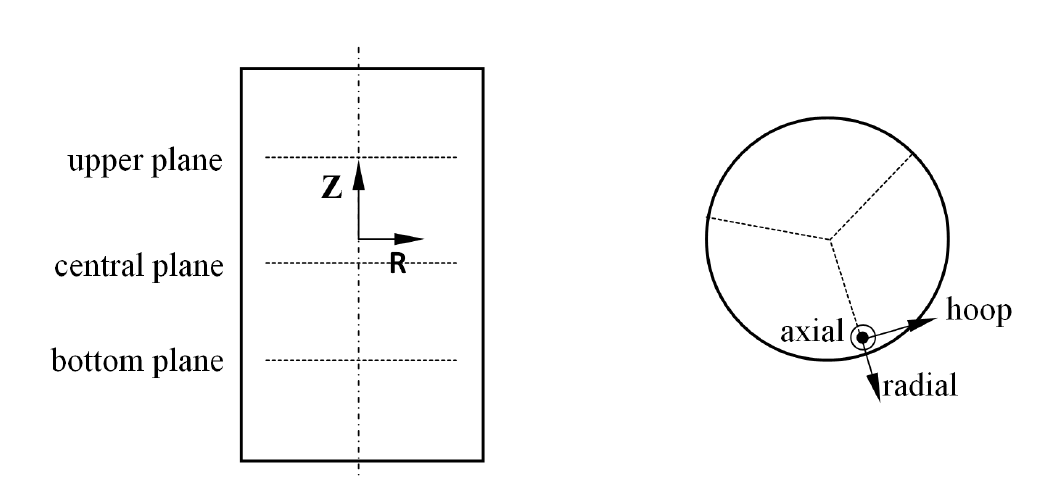
Figure 14. Schematic illustration of planes and directions of measurement.